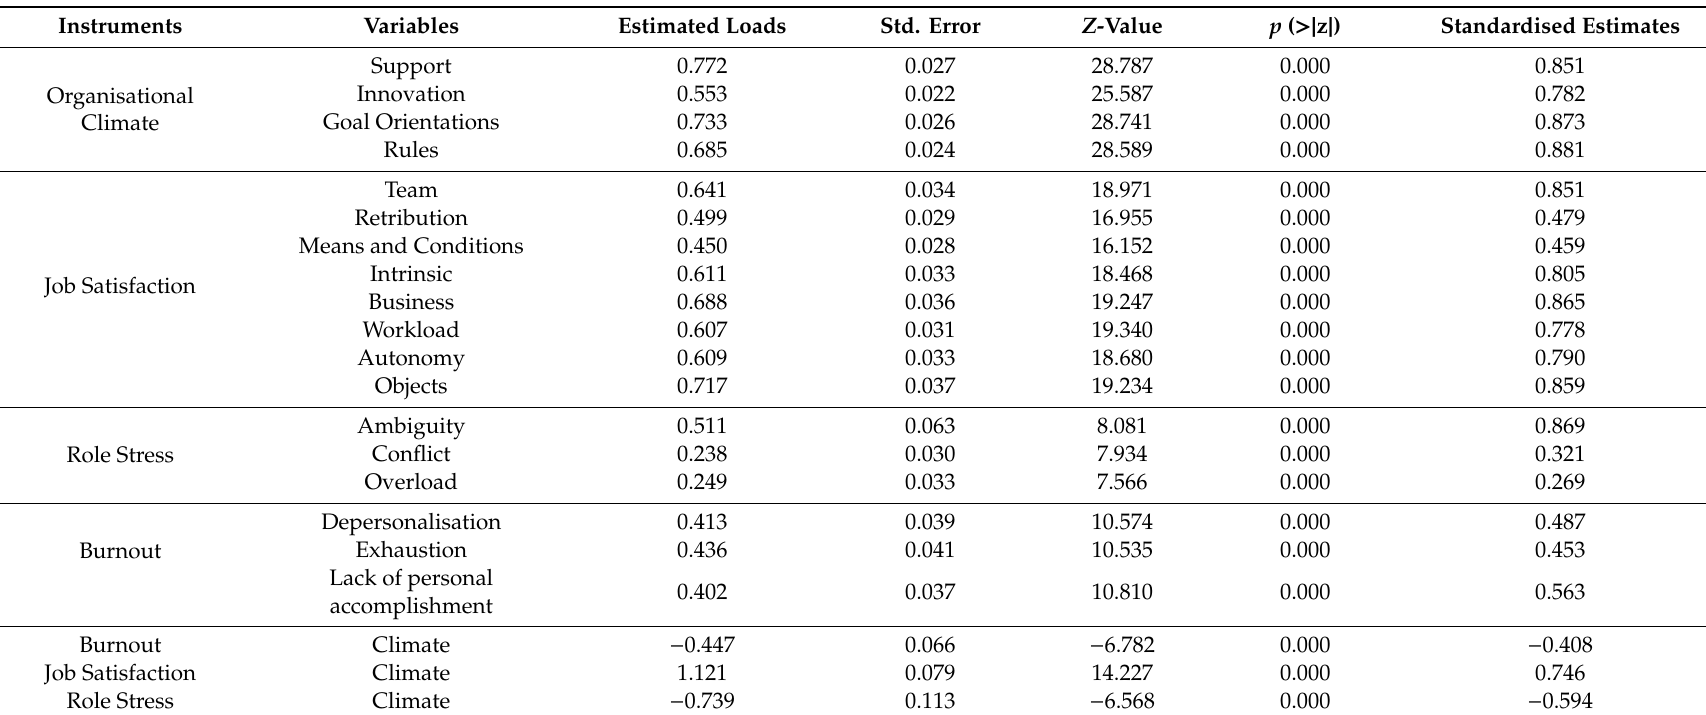
Table 1. Estimate parameters for the Job Demands-Resources